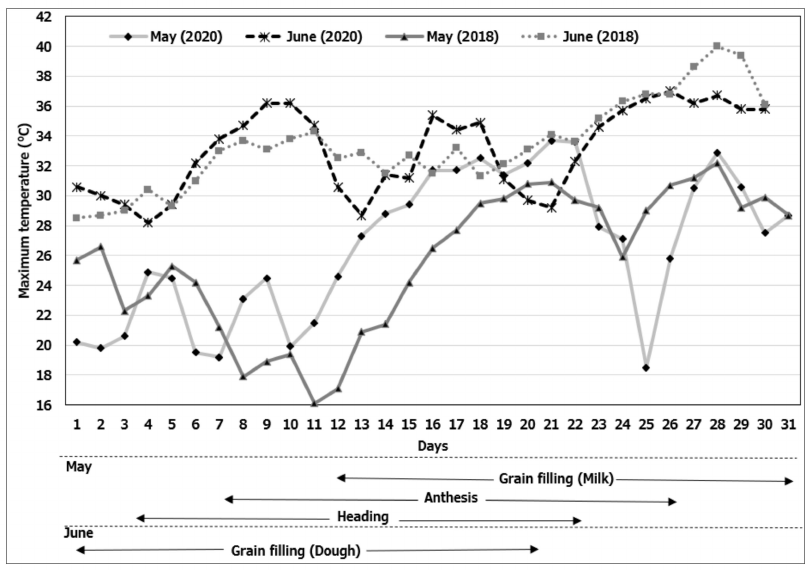
Figure 2. Daily maximum temperatures measured in May and June of both